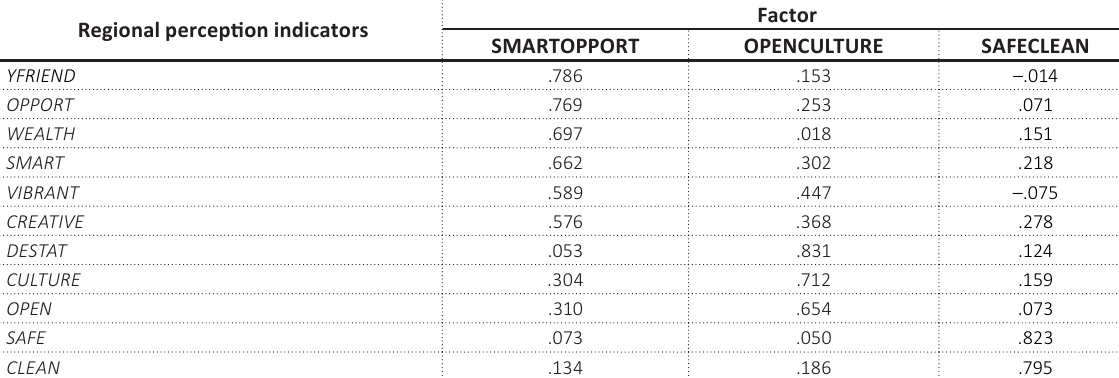
Table 3. Rotated factors matrix of the regional perception indicators